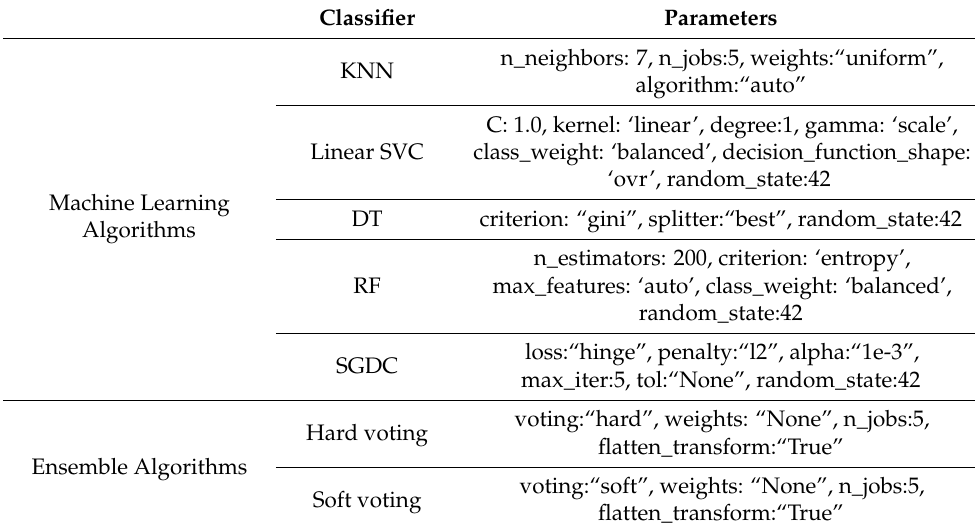
Table 4. Individual ML classifiers and ensemble models parameters.